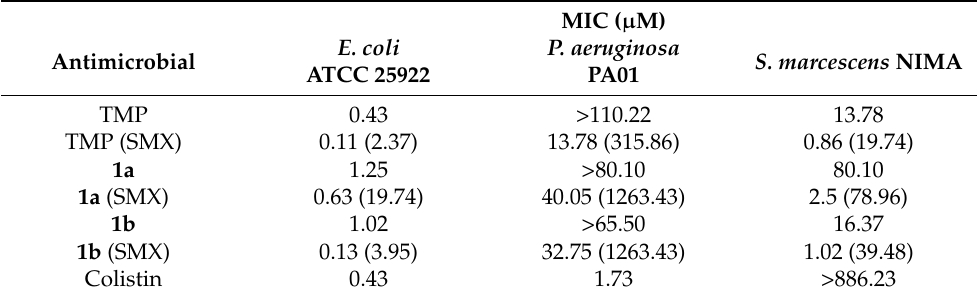
Table 1. Minimum inhibitory concentration (MIC, µ M) of trimethoprim (TMP) and compounds 1a and 1b tested alone and in combination with sulfamethoxazole (SMX) and colistin against Escherichia coli ATCC 25922, Pseudomonas aeruginosa PAO1, and Serratia marcescens NIMA. Data for P. aeruginosa PAO1 and E. coli ATCC 25922 were already reported [6].